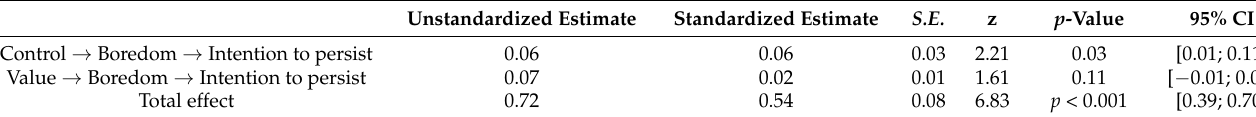
Table 4. Indirect and direct